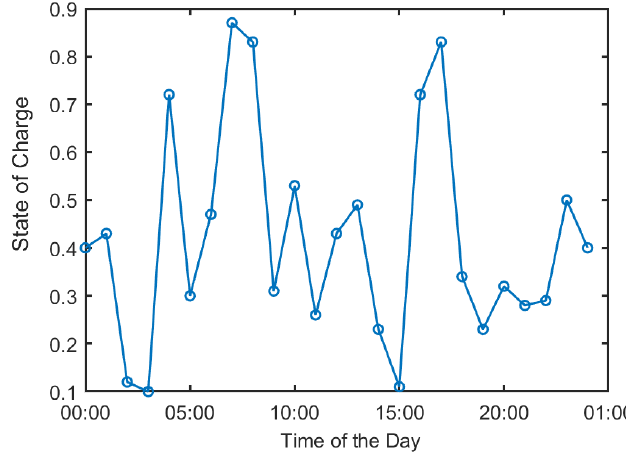
Figure 6. State of charge of storage batteries.